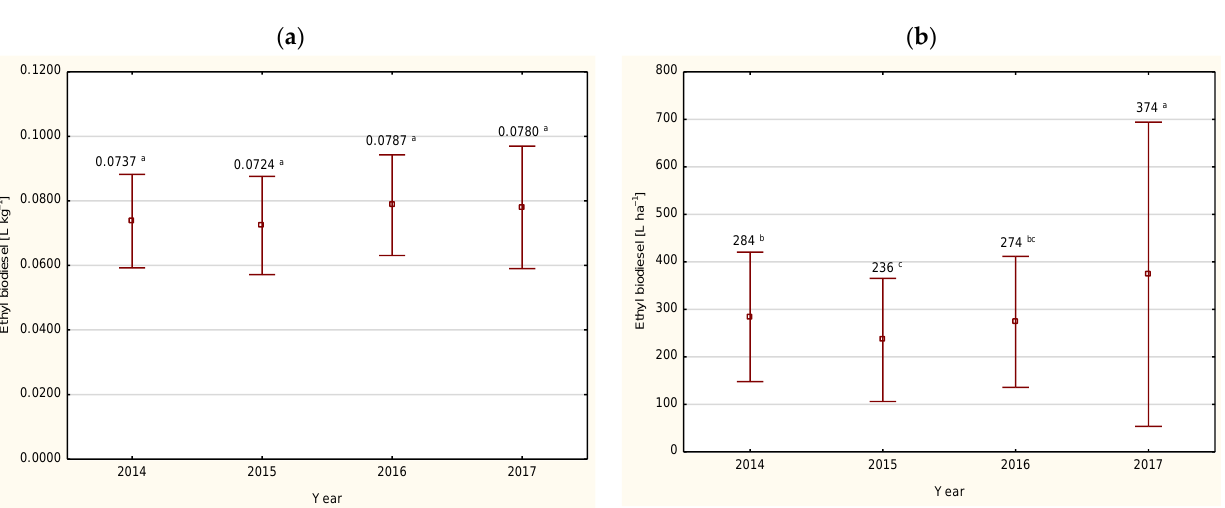
Figure 8. Volume of ethyl biodiesel (mean value and standard deviation), obtained from corn grain ( a ) and ethyl biodiesel yield from a hectare ( b ), considering year of experiment. a,b,c — Values followed by the same letters do not differ significantly in Tukey’s (HSD) test ( p < 0.05).